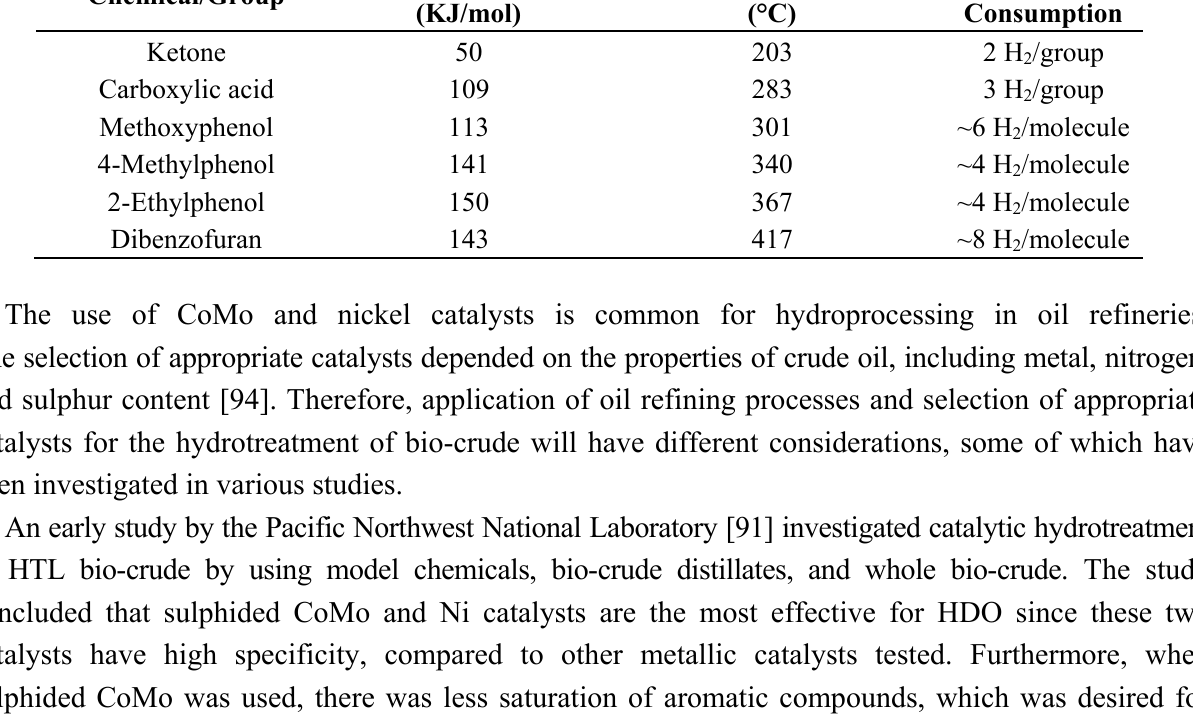
Table 5. Activation energies, iso-reactive temperature and hydrogen consumption of hydrodeoxygenation of model compounds with a CoMo catalyst, presented by Grange et al. [92]. Activation Energy Iso-Reactive Temperature Hydrogen Chemical/Group (KJ/mol) (°C) Consumption Ketone 50 203 2 H /group 2 Carboxylic acid 109 283 3 H /group 2 Methoxyphenol 113 301 ~6 H /molecule 2 4-Methylphenol 141 340 ~4 H /molecule 2 2-Ethylphenol 150 367 ~4 H /molecule 2 Dibenzofuran 143 417 ~8 H 2